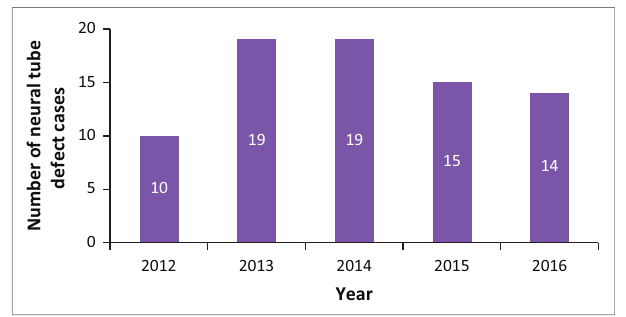
FIGURE 1: Number of neural tube defect (NTD) cases per year at Universitas Hospital.